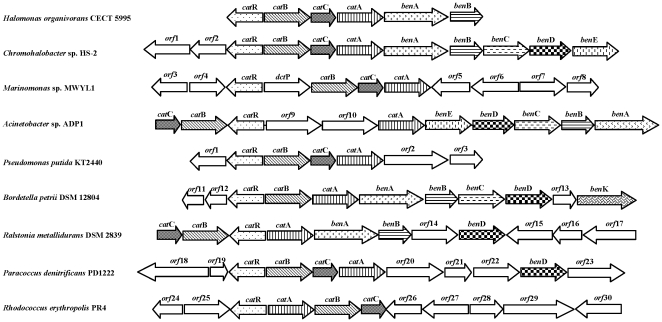
Comparative analysis of cat and ben genes from H. organivorans and other strains.The direction of transcription is indicated by the arrowheads. catA, catechol 1,2-dioxygenase; catB, cis,cis-muconate cycloisomerase; catC, muconolactone delta-isomerase; catR, lysR-type transcriptional regulator; benA, benzoate 1,2-dioxygenase large subunit; benB, benzoate 1,2-dioxygenase small subunit; benC, benzoate 1,2-dioxygenase reductase subunit; benD, 1,6-dihydroxy cyclohexe-2,4-diene-1-carboxylate dehydrogenase; benE, MFS family benzoate membrane transporter; benK, benzoate transporter protein.